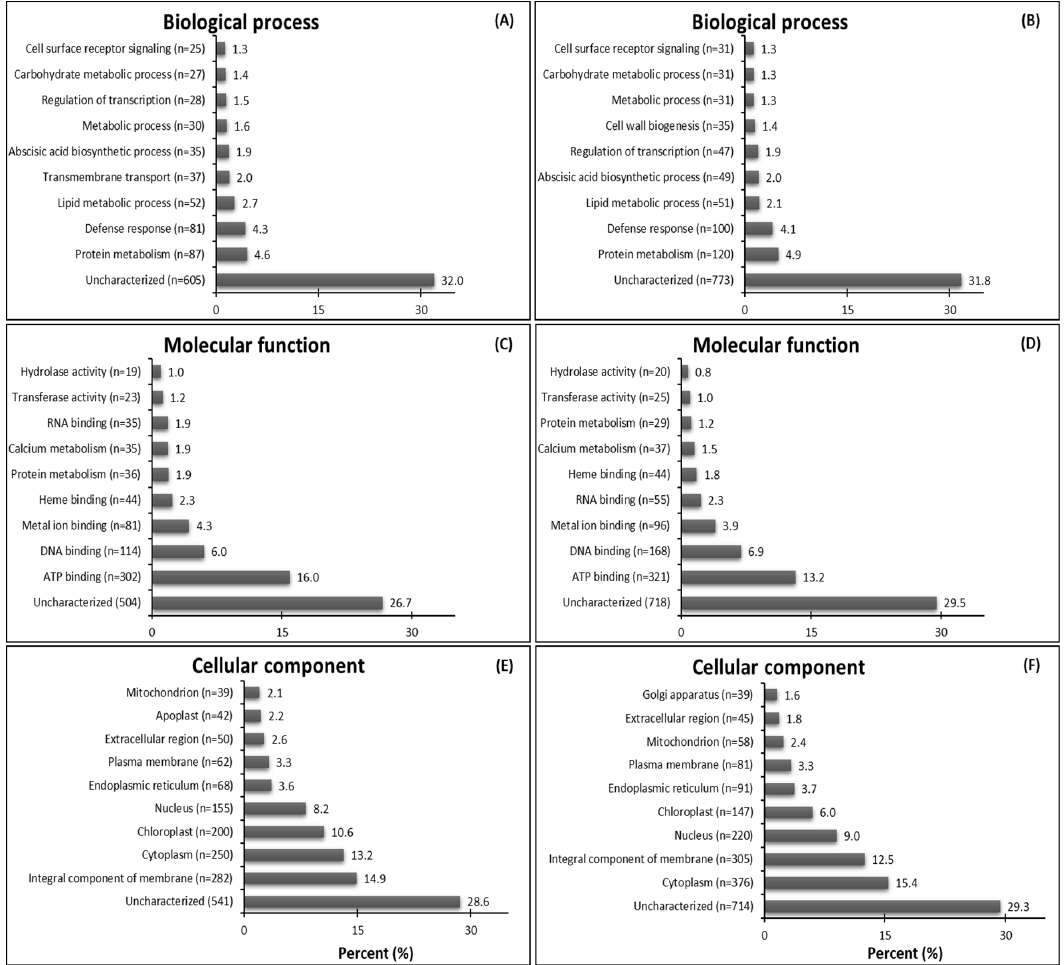
Figure 2. Summary of top ten gene ontology (GO) terms identified as up-regulated genes (DEGs-up) in glyphosate-resistant and -sensitive C. bonariensis biotypes. Annotated sequences were classified into the biological process, molecular function, and cellular component. ( A , C , E ) GR—up-regulated DEGs, n = 1770; ( B , D , F ) GS—up-regulated DEGs, n =